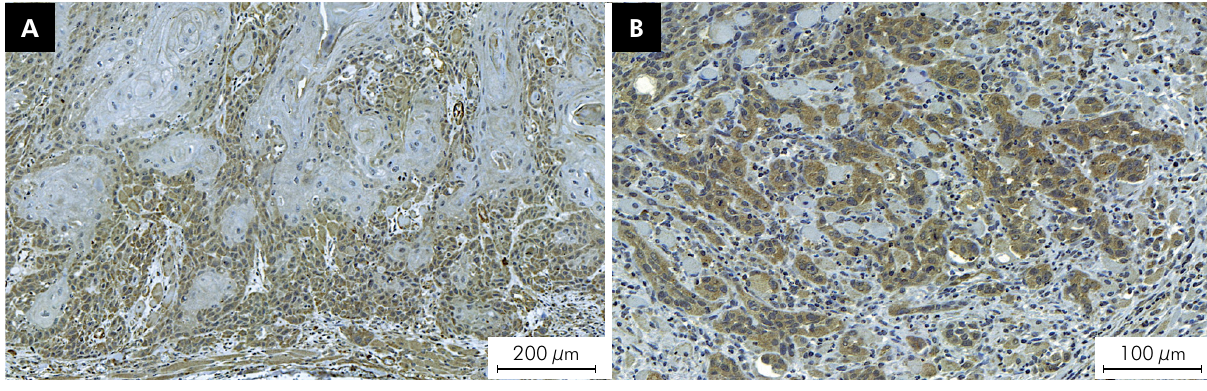
Figure 1. Immunohistochemical expression of uPA in SCCOT. (a) Low magnification showing the immunostaining at the invasion front and in the tumor core. (b) High magnification showing the immunostaining at the invasion